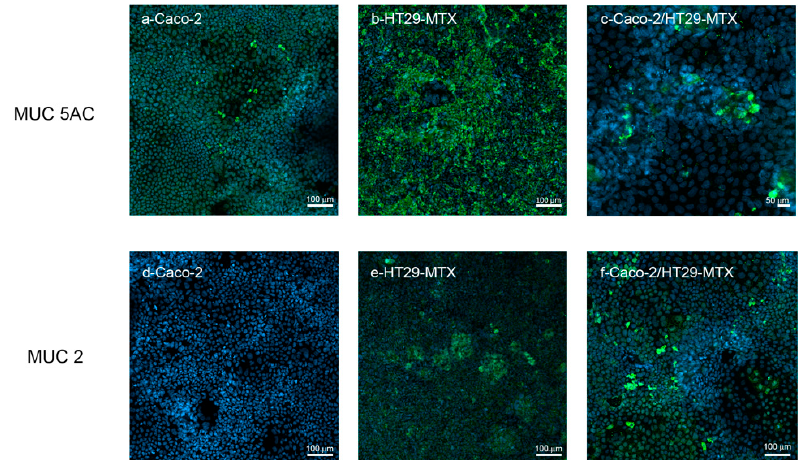
Figure 9. MUC 2 and MUC 5 AC (green) labelling in Caco-2 monoculture, HT29-MTX monoculture and Caco-2/HT29-MTX co-culture analyzed by confocal microscopy. The cells were counterstained with Hoechst 33258 (blue) for nuclei identification.